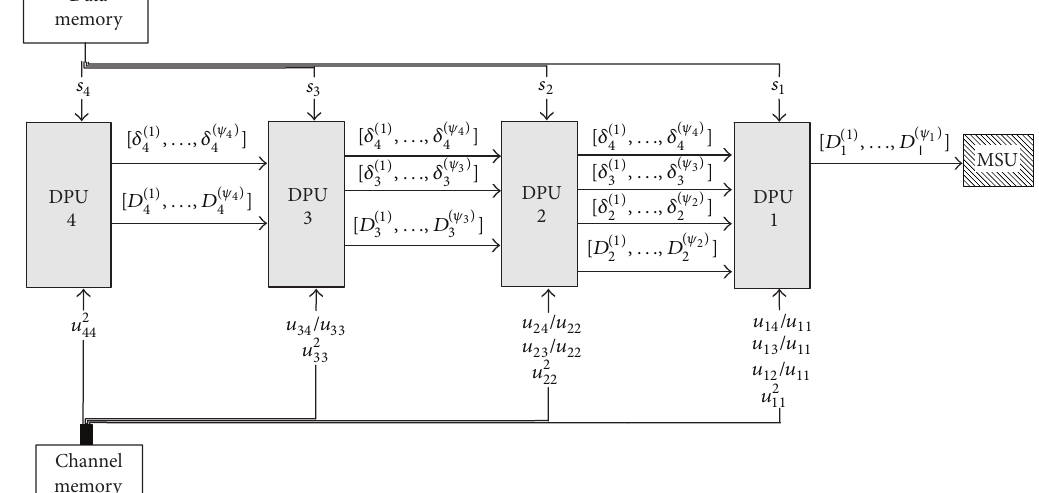
Figure 2: General hardware architecture of the fixed-complexity tree-search techniques for an 𝑁 = 4 user system.